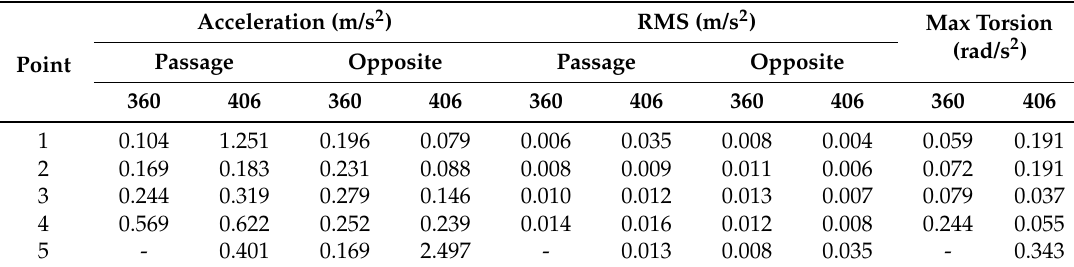
Table 2. Maximum acceleration, root mean square (RMS) and torsional acceleration for the filtration of vibration measurements.